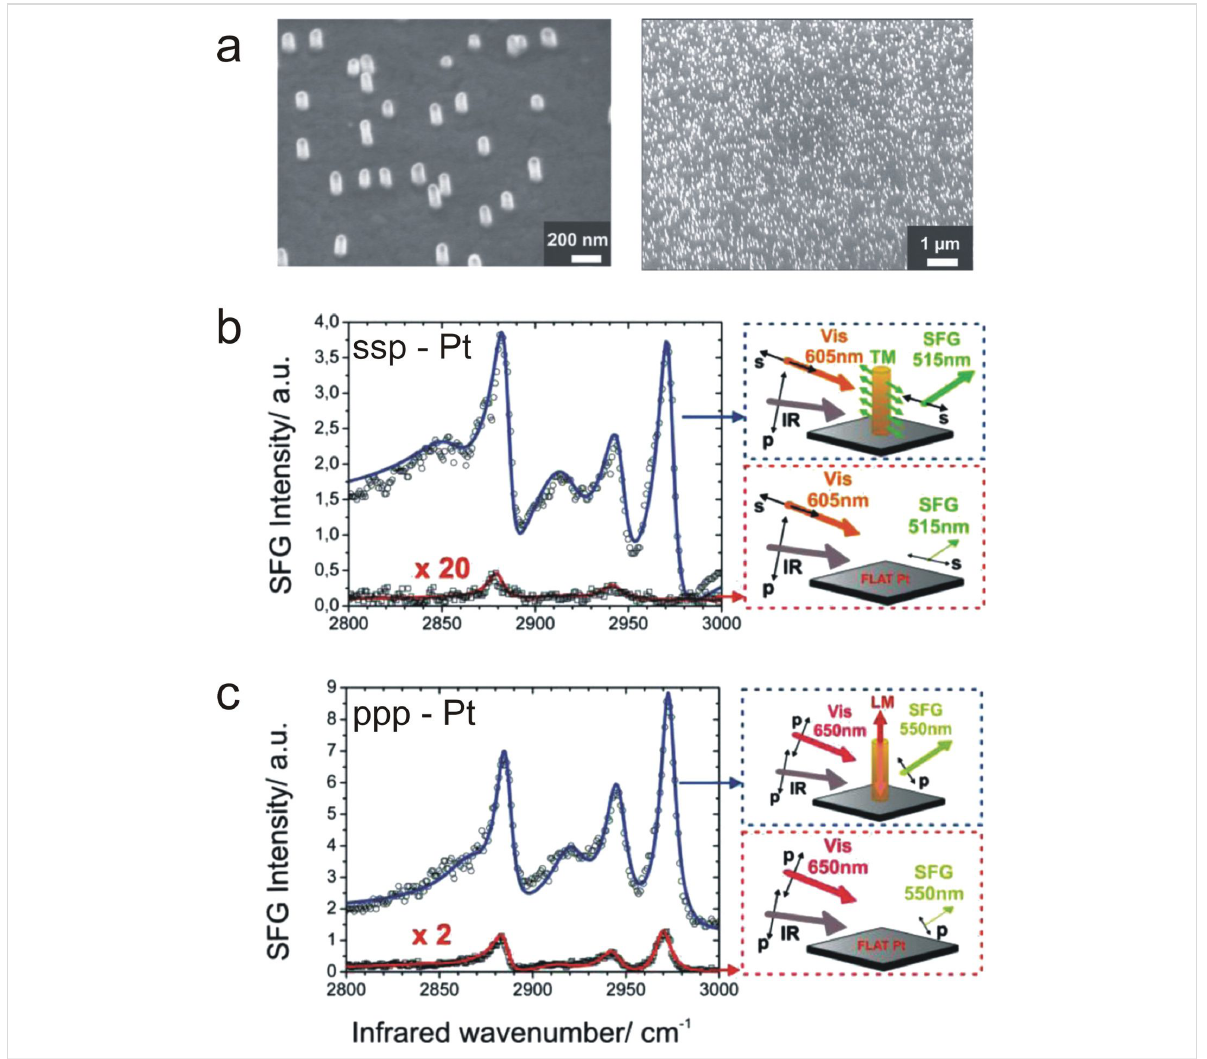
Figure 8: (a) Scanning electron microscopy (SEM) images of gold nano-antennas possessing an average height of 140 nm and diameter of 70 nm. SFG spectra of a dodecanethiol SAM (b) in ssp polarization with a selective excitation of the transverse plasmon mode and (c) in ppp polarization with a selective excitation of the longitudinal plasmon mode. The red curves stand for a DDT SAM chemisorbed on a flat platinum substrate, whereas the blue curves correspond to a DDT SAM over gold nano-antennas standing on flat platinum. Pictures on the right illustrate the experimental